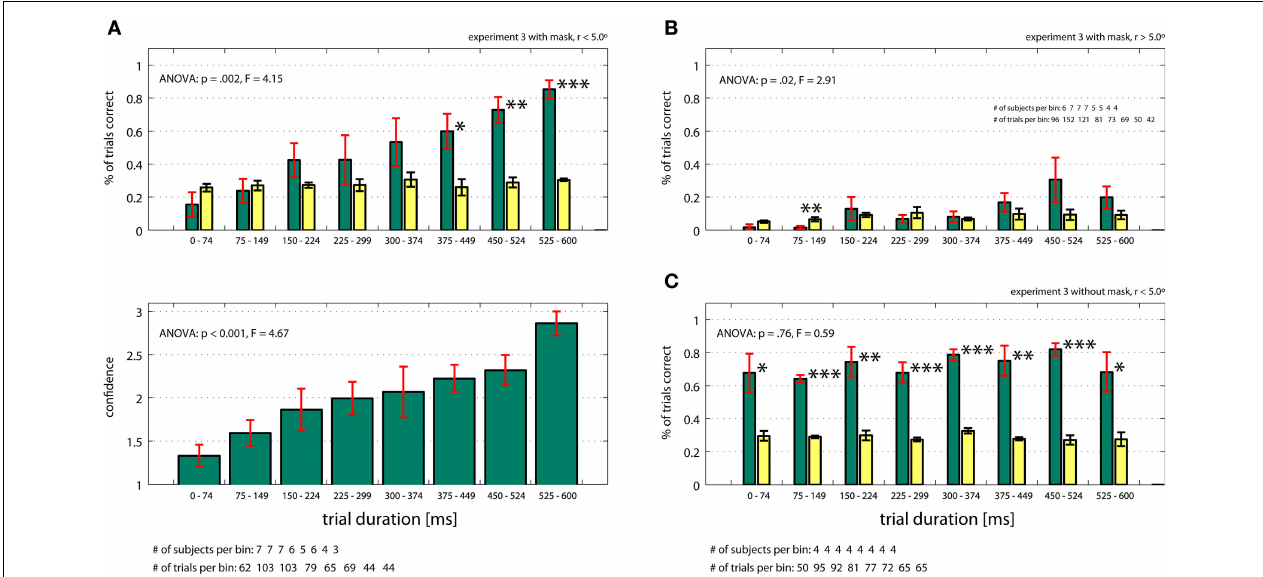
> 375 ms. (B) It targets were located further then 5.0º from fi xation, performance (green bars) was never signifi cantly higher than chance (yellow bars) and depended only weakly on time (ANOVA, p = 0.02). (C) Without the mask (and r < 5.0º), performance is independent of time ( p = 0.76, ANOVA) and always different from chance. All ANOVA values refer to a one-way ANOVA (see Supplementary Material for